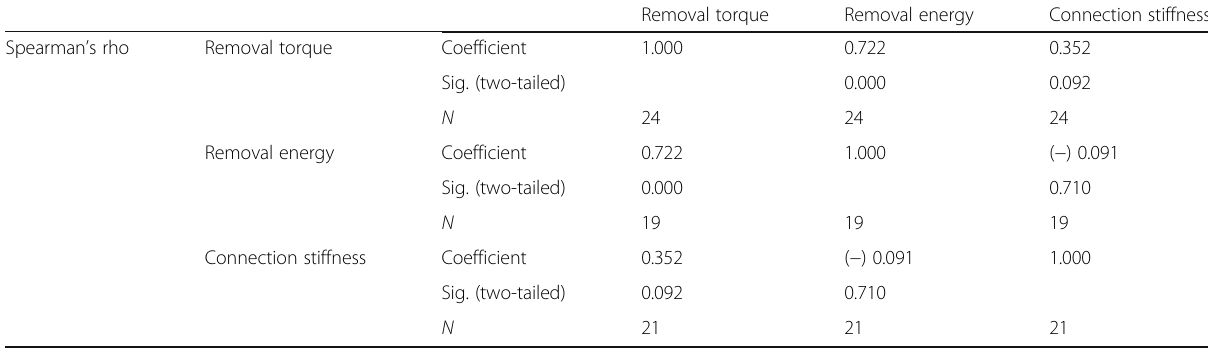
Table 2 Spearman rank correlation coefficient values between removal torque (N cm), removal energy [N cm/rad (0.01 J)], and connection stiffness [N cm/rad] for SAE-HD and SAE implants at 2 and 4 weeks postoperatively ( n = 6; P < 0.01) Removal torque Removal